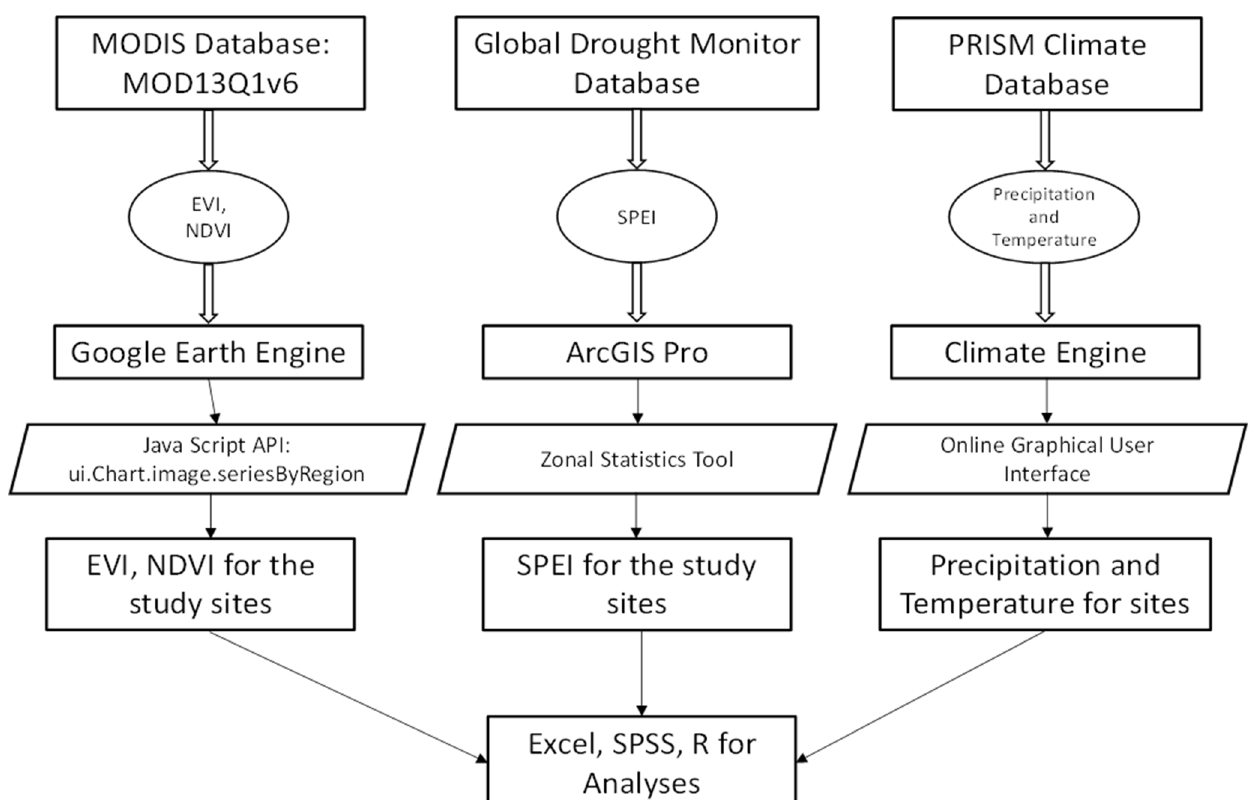
Figure 2. A flowchart showing the steps of data acquisition and analyses for this